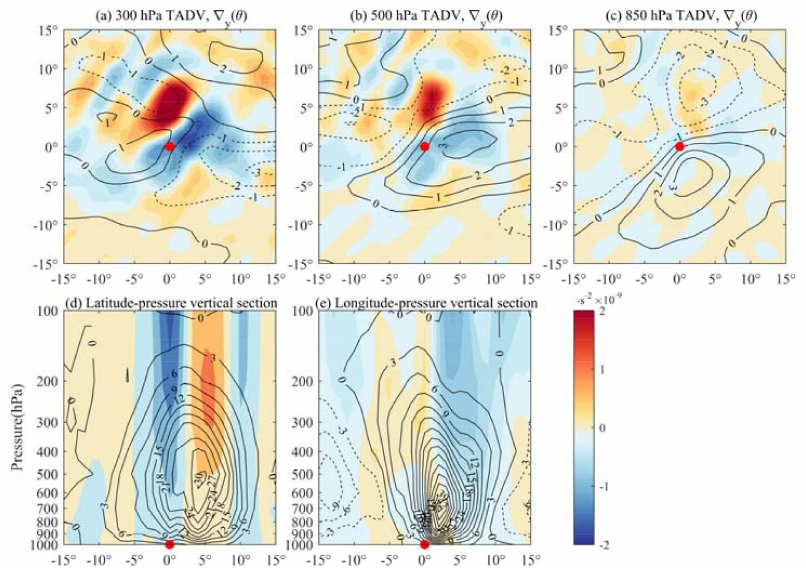
Figure 7. Composite horizontal distribution of the meridional potential temperature gradient (black contours, unit: 10 − 6 K m − 1 ), the temperature advection induced vorticity change (the TADV term, color shading, unit: 10 − 9 s − 2 ) in the cyclone region at the 300 hPa ( a ), 500 hPa ( b ) and 850 hPa ( c ), respectively under the cyclone centered coordinate, and vertical sections of the vertical velocities (contours, unit: − 1 hPa/s) and the temperature advection induced vorticity change (the TADV term, color shading, unit: 10 − 9 s − 2 ) along the 0 ◦ latitude ( d ) and 0 ◦ longitude ( e ) in the cyclone centered coordinate based on the selected cyclones in the Northwest Pacific. The red spot is the center of the extratropical cyclone at the sea level.